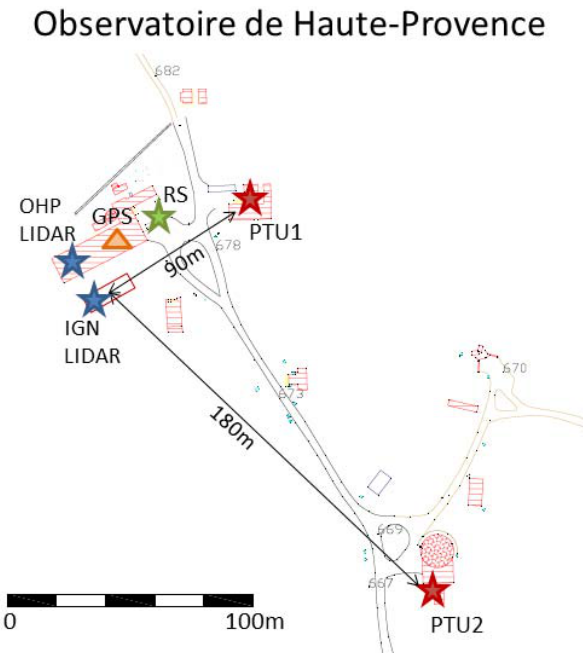
Fig. 1. Location of the infrastructures and instruments participat- ing in DEMEVAP 2011 experiment at the Observatoire de Haute- Provence facility (OHP, 43.93 ◦ N, 5.71 ◦ E; 680m above sea level): NDACC-OHP lidar and IGN-LATMOS lidar (blue stars), GPS an- tennas (orange triangles), radiosonde launch pad (green star), and 10m masts with PTU1 and PTU2 (red stars); PTU1 is at 90m and PTU2 at 180m from IGN-LATMOS